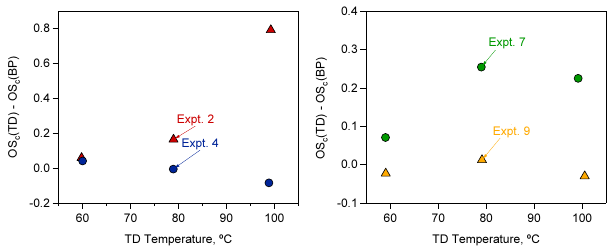
Figure 5. Comparison of the difference in oxidation state of de- nuded and total OA versus TD temperature for two unseeded ex- periments (2 and 4, left panel) and two seeded experiments (7 and 9, right panel). For OA of intermediate oxidation state (around 0, Expts. 4 and 9), oxidation state of the denuded OA is similar to the oxidation state of the full OA, implying that oxidation state does not correlate significantly with volatility. For OA of higher or lower oxidation state (Expts. 2 and 7, respectively) oxidation state anti- correlates with volatility, shown here as an increase in oxidation state difference with TD